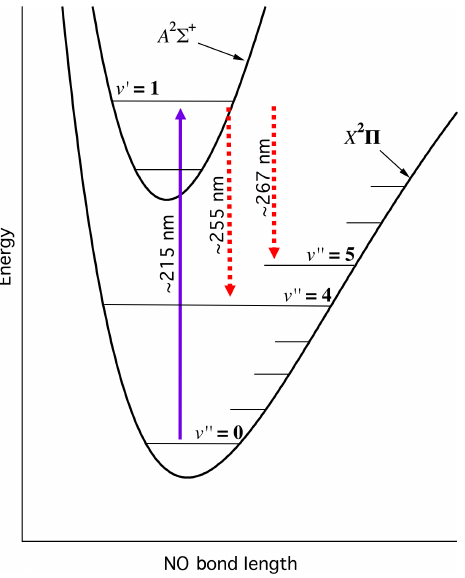
Figure 2. Energy level schematic of NO-LIF system. Schematic is qualitative and not intended to be to scale.